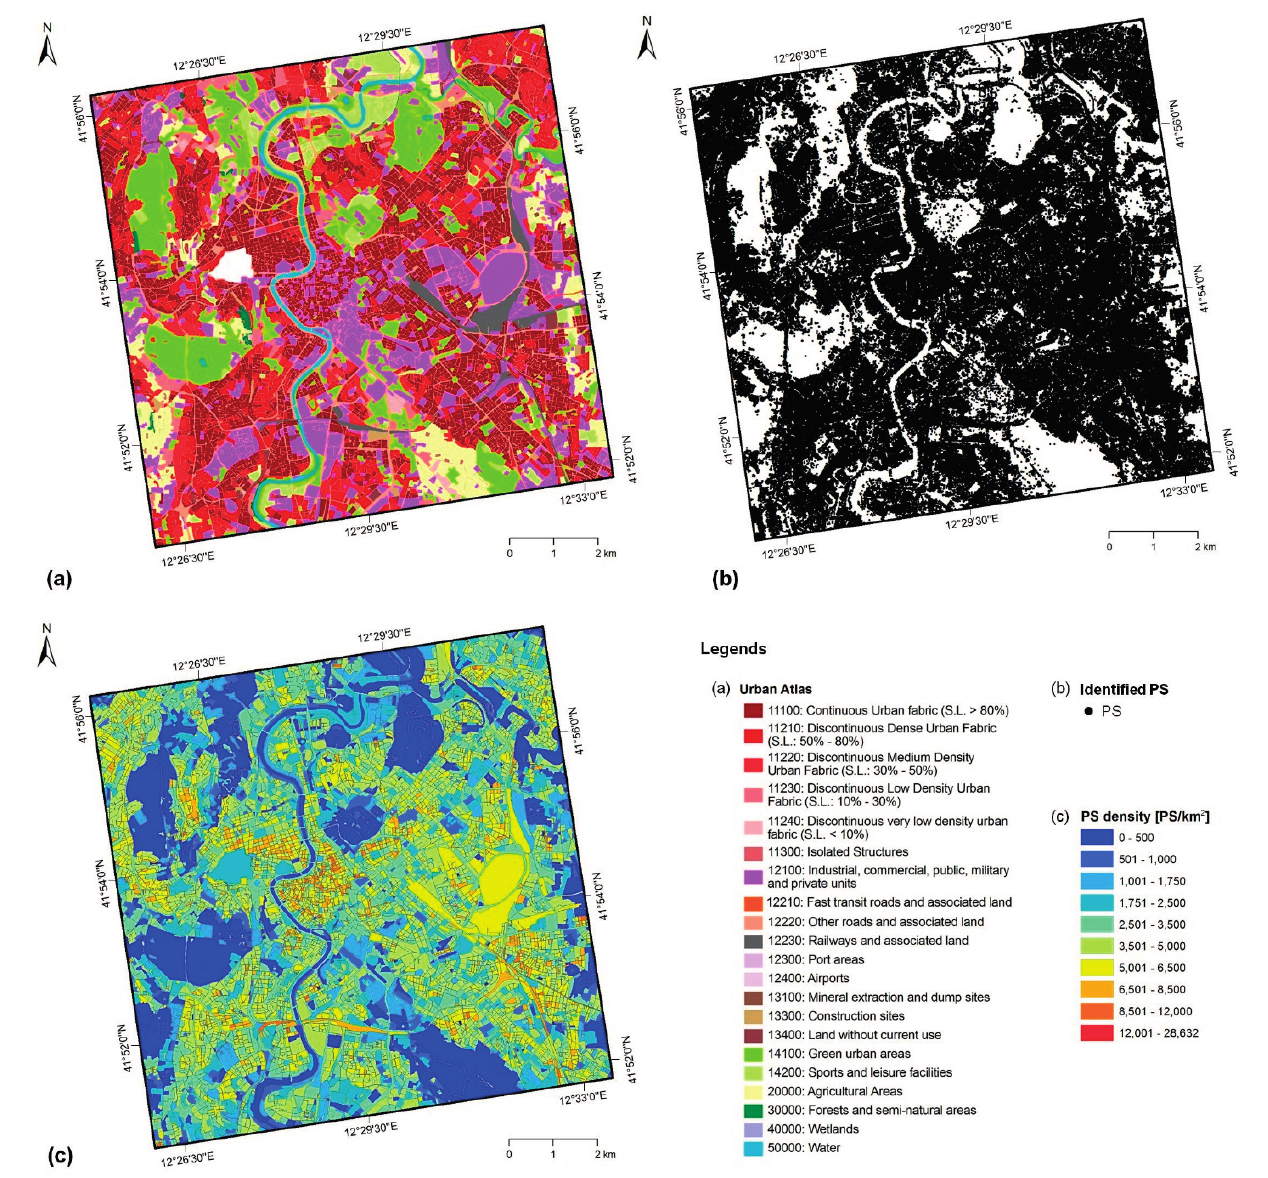
Figure 2. ( a ) Land cover for the city of Rome within the processed subset ( cf . Figure 1) from the Global Monitoring for Environment and Security (GMES) European Urban Atlas (IT001L) of Rome at 1:10,000 scale [23]; ( b ) distribution of COSMO-SkyMed PS targets; ( c ) PS density observed across the Urban Atlas, including calculation for the territory of the Vatican, not included in the Urban Atlas ( i.e. , 1223 PS targets identified, 2427 PS/km 2 on